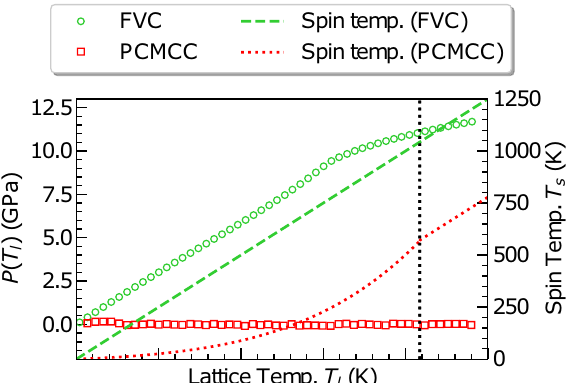
Fig. 6 Pressure and spin temperature conditions. The FVC data is represented by the symbol/line combination / . Meanwhile, PCMCC data is represented by the symbol/line combination / . Symbols, associated to the left axis, represent the pressure evolution in the FVC and PCMCC (similar to the PCC), as a function of lattice temperature. Doted lines, associated to the right axis, represent the spin thermostat temperature for the PCMCC and FVC (similar to PCC) as a function of the lattice